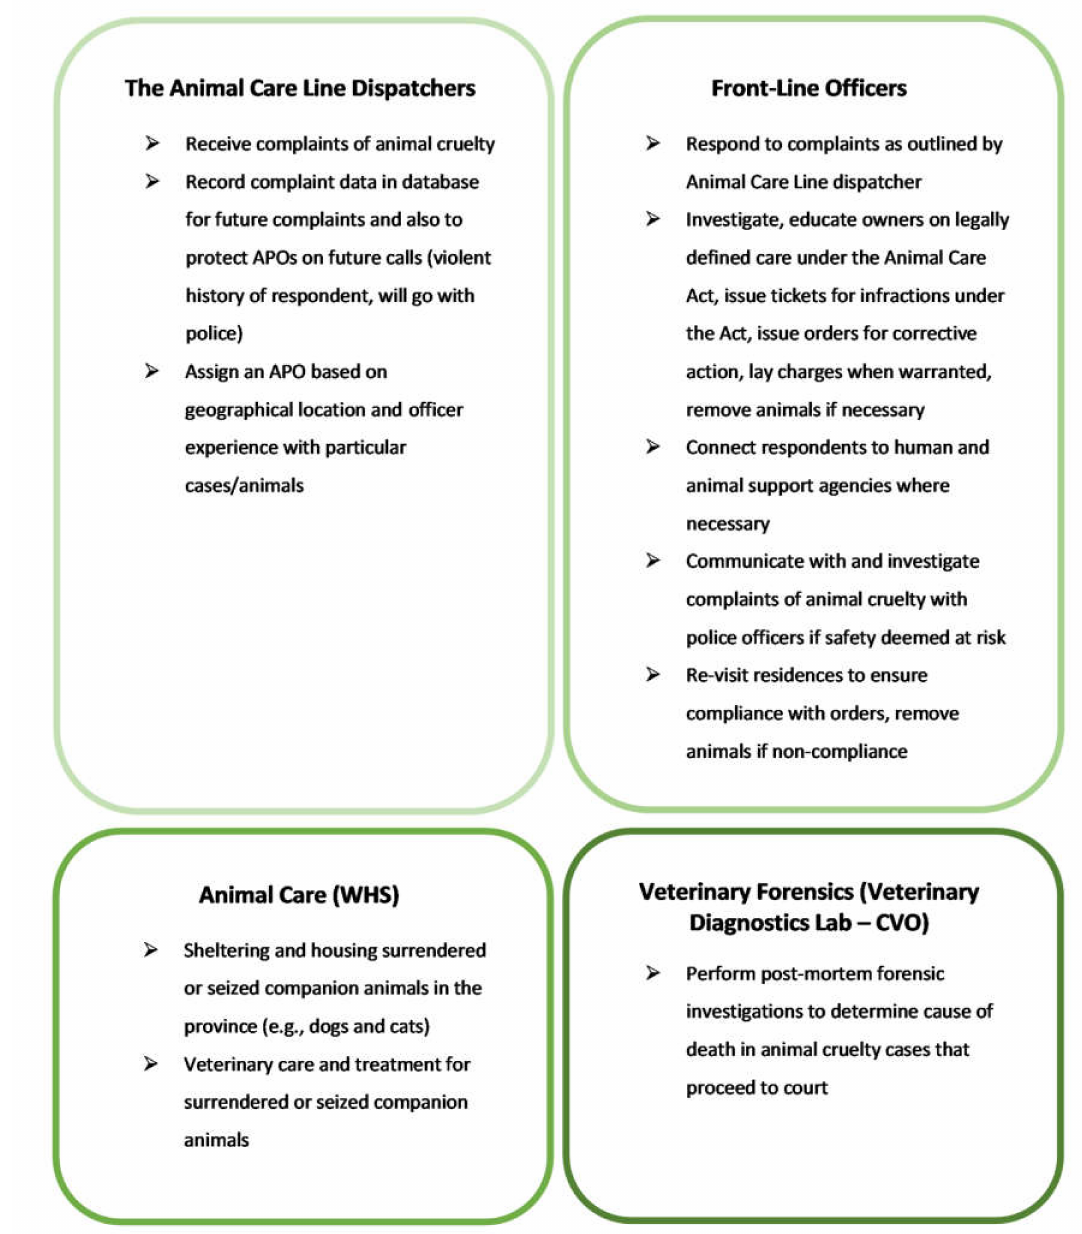
Figure 2. Basic Process of Manitoba Cruelty